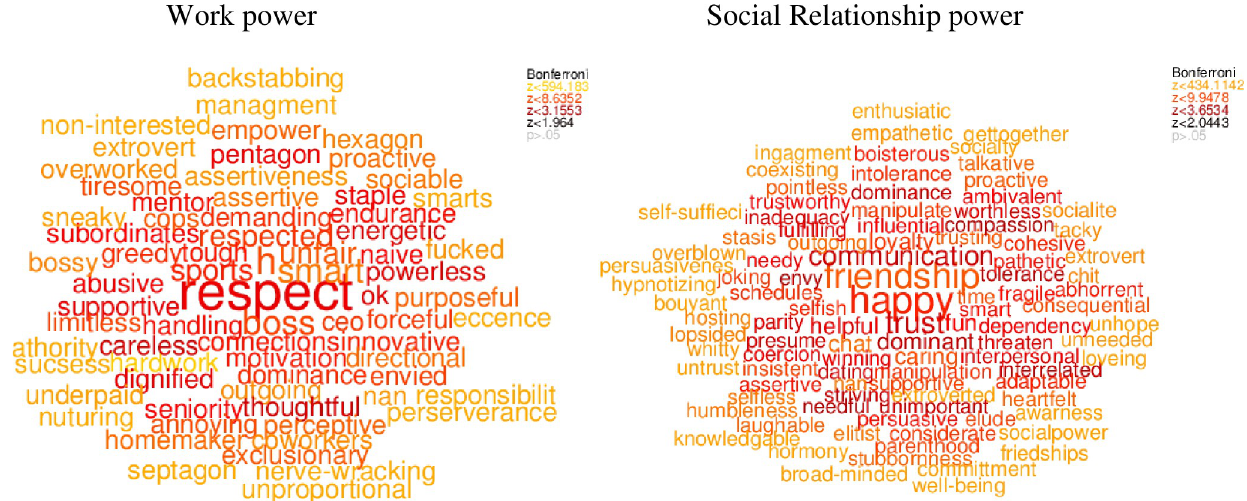
Fig 2. Word clouds describing the participant’s view of work and social relationship power. Note . The figures were created using the same method as in Fig 1, and based on word data answering the semantic questions “Please write five words that best describe your view of work power” (left panel) and “Please write five words that best describe your view of social relationship power” (right panel) were the semantic similarity were quantified in relation to a random set of words from Google N-gram.